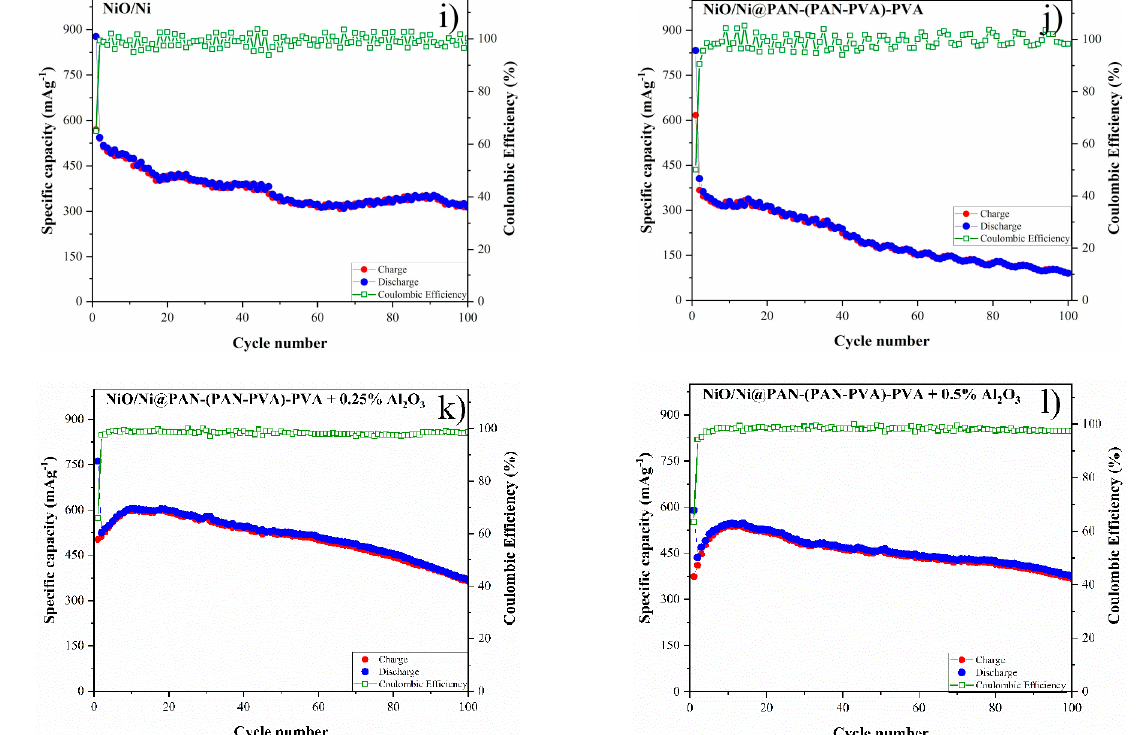
Figure 6. CV plateaus and charge–discharge curves of ( a , e ) NiO/Ni foam, ( b , f ) NiO/Ni@PAN-(PAN-PVA)-PVA, ( c , g ) NiO/Ni@PAN-(PAN-PVA)-PVA with addition of 0.25 wt% Al 2 O 3 , ( d , h ) NiO/Ni@PAN-(PAN-PVA)-PVA with addition of 0.5 wt% Al 2 O 3 electrodes. Cycle performance for 100 cycles of ( i ) NiO/Ni foam, ( j ) NiO/Ni@PAN-(PAN-PVA)-PVA, ( c ) NiO/Ni@PAN-(PAN-PVA)-PVA with addition of 0.25 wt% Al 2 O 3 ( k ), NiO/Ni@PAN-(PAN-PVA)-PVA with the addition of 0.5 wt% Al 2 O 3 electrodes ( l ).